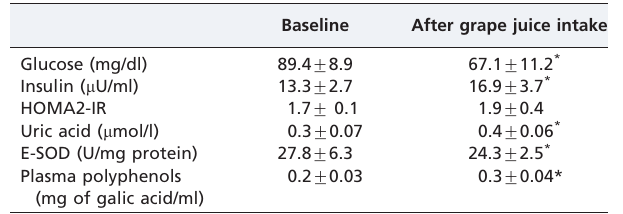
Table 1 - Biochemical parameters for glycemic homeostasis and antioxidant status in triathletes before (baseline) and after 20 days of organic grape juice intake (n= 10).